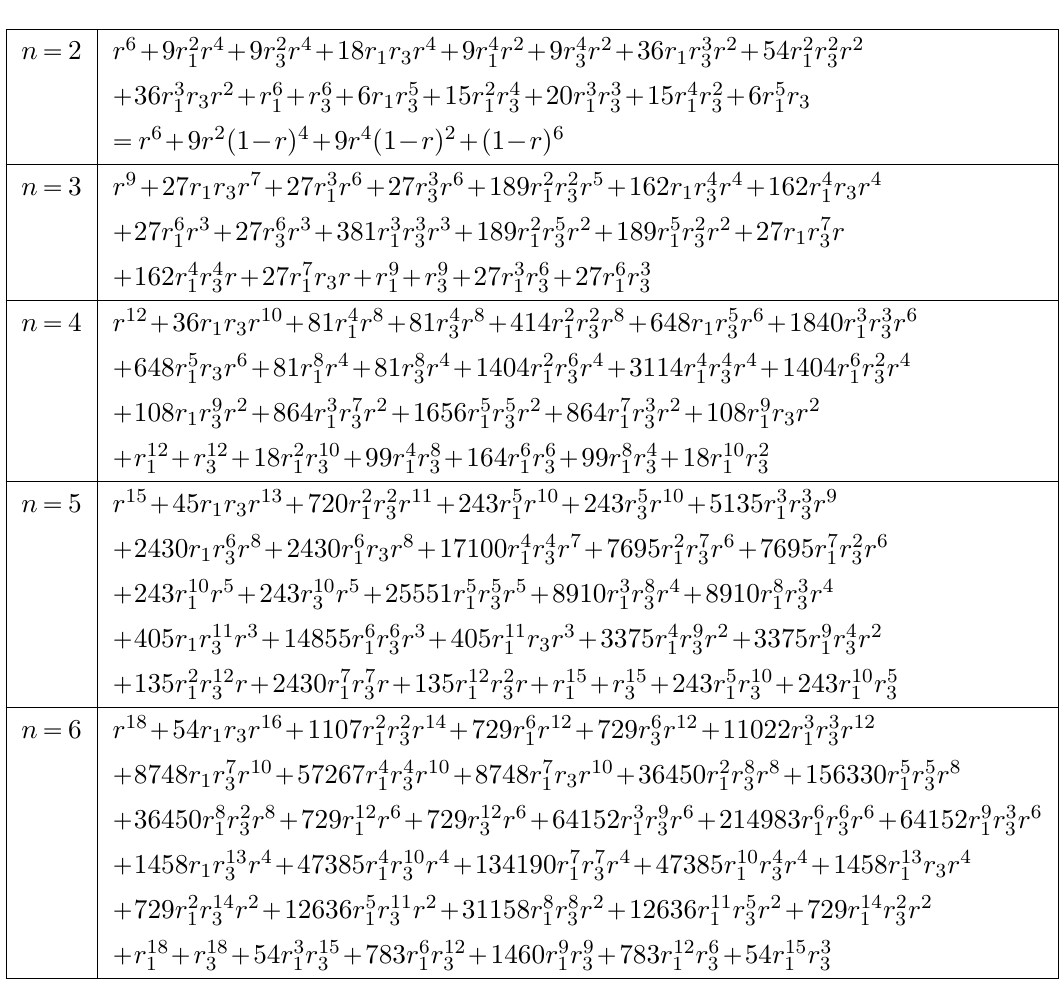
Table 2 . The replica negativities exp p E 3